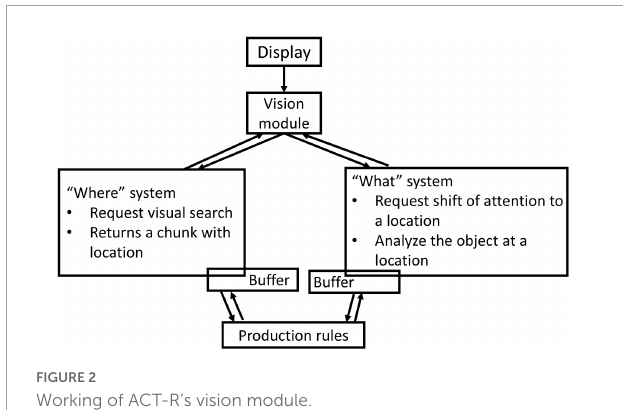
FIGURE2 Working of ACT-R’s vision module.